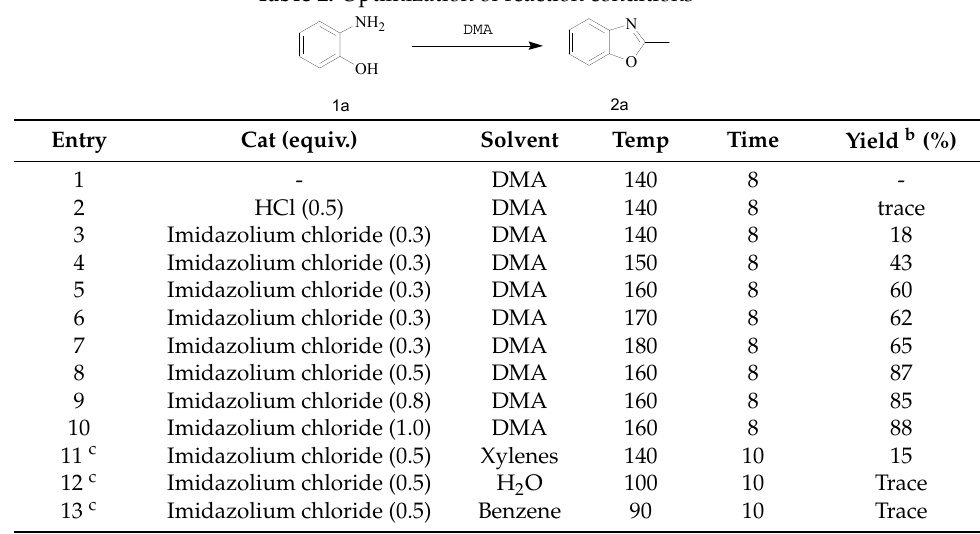
Table 2. Optimization of reaction conditions a.